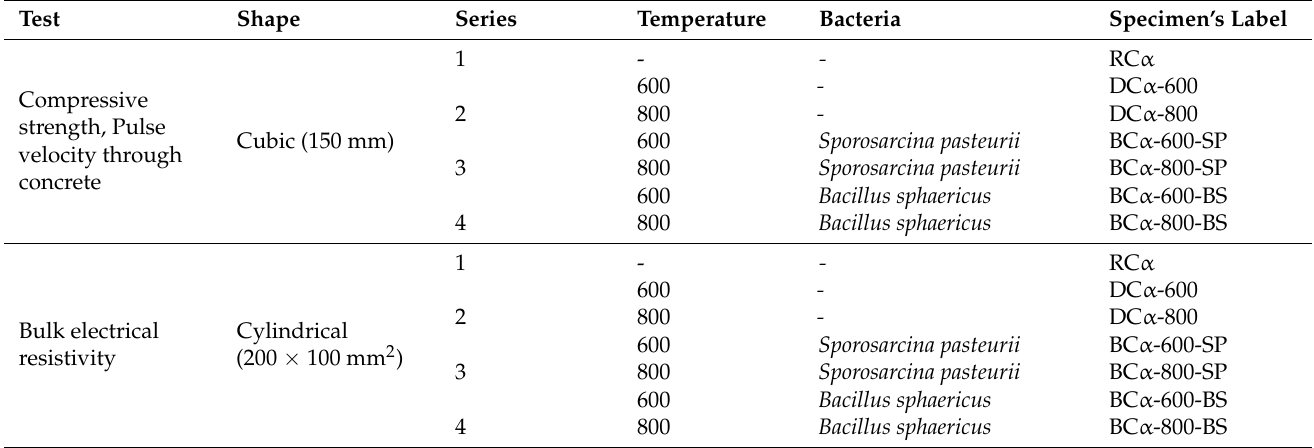
Table 2. Specification and labels of the